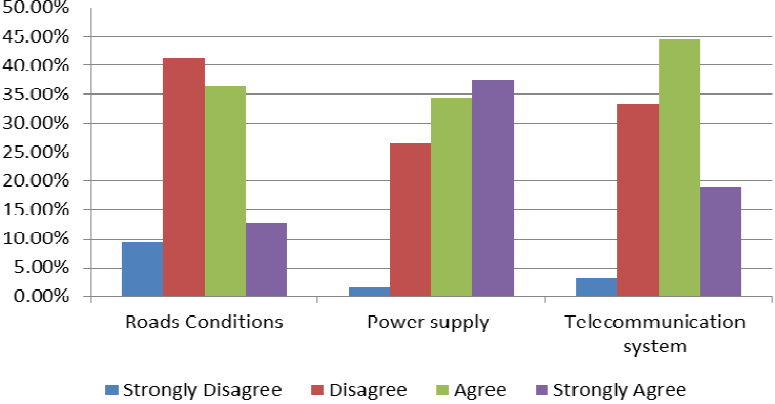
Fig. 4. Participants response with regards to infrastructure